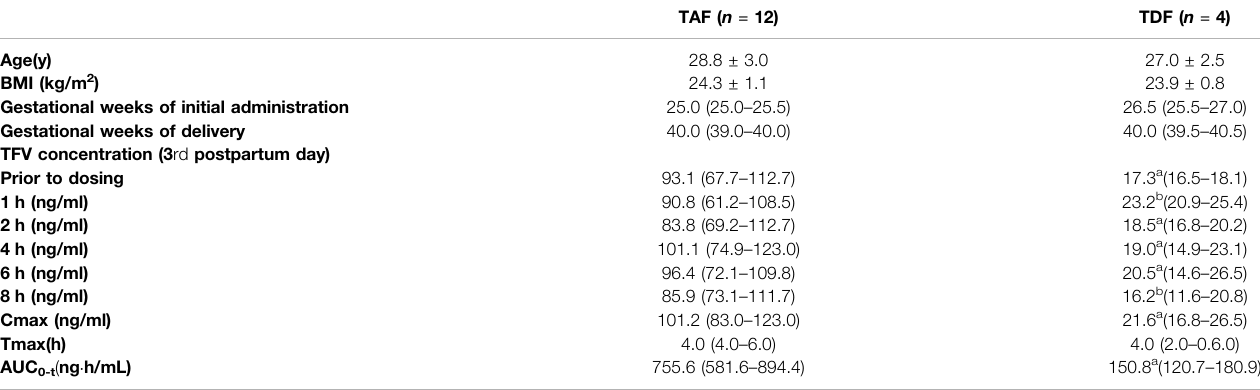
TABLE 4 | Participant characteristics and pharmacokinetic analysis.